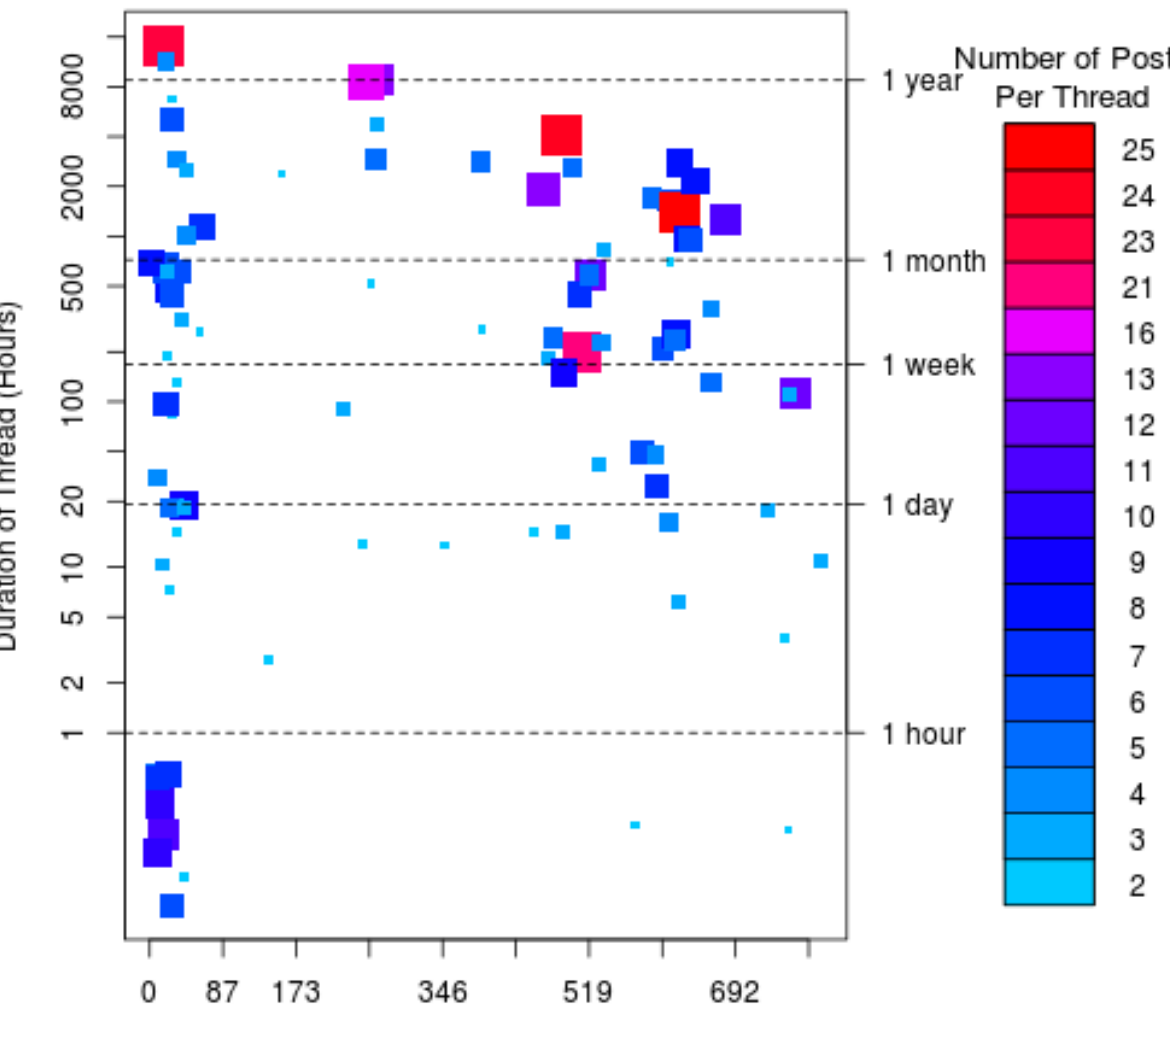
Figure 3. A plot detailing the number of posts and duration of threads as a function of time in the forum. The x-axis represents the date of the first post in the thread, the y-axis represents the time between the first and last post (note that the y-axis is in a log-scale). Each square represents a thread, and the size and colour of the square are defined by the number of posts in the